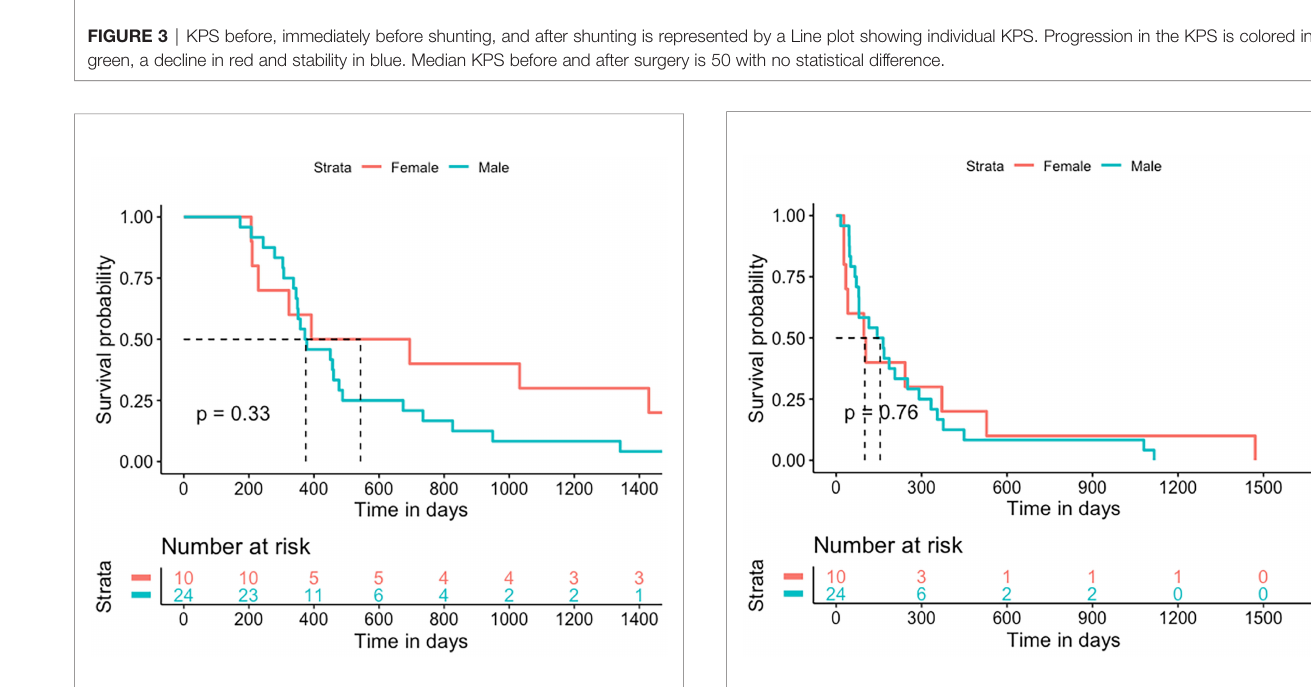
FIGURE 4 | Kaplan-Meier statistics for the overall survival of GBS patients treated for hydrocephalus. Median OS was 385 days (IQR 311-724).